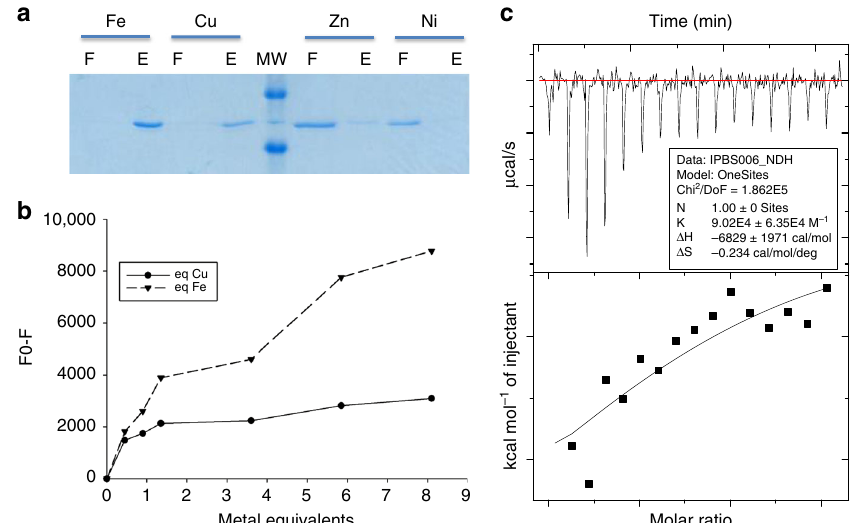
Fig. 2 IbpS is a metal-binding protein. a IbpS (10 µ g) in 100 µ l of A buffer was incubated with 100 µ l of Fe-NTA, Cu-NTA, Ni-NTA, or Zn-NTA resins for 15 min. After centrifugation the supernatants ( fl owthroughs) were removed and the resins were washed three times with 1 ml of buffer A. The protein was eluted with 100 µ l of 50 m M EDTA and 10 µ l of fl owthrough (F) or eluate (E) was loaded onto an SDS-PAGE gel. b Fluorescence spectra of 70 µ M IbpS titrated with the indicated equivalents of FeCl 3 (dashed line) or CuCl 2 (solid line). The F0-F values are plotted. c Isothermal titration calorimetry of IbpS. Cu (II)Cl 2 (1 m M ) titrated into apo-IbpS (120 µ M ) in 10 m M Tris-HCl buffer (pH 7.0) at 30 °C. A blank run consisting of CuCl 2 dilution in the experimental buffer was performed and values subtracted from the assay. Top, raw data. Bottom, plot of integrated heats versus the Cu/IbpS ratio. The solid line represents the best fi t for a one-site binding model